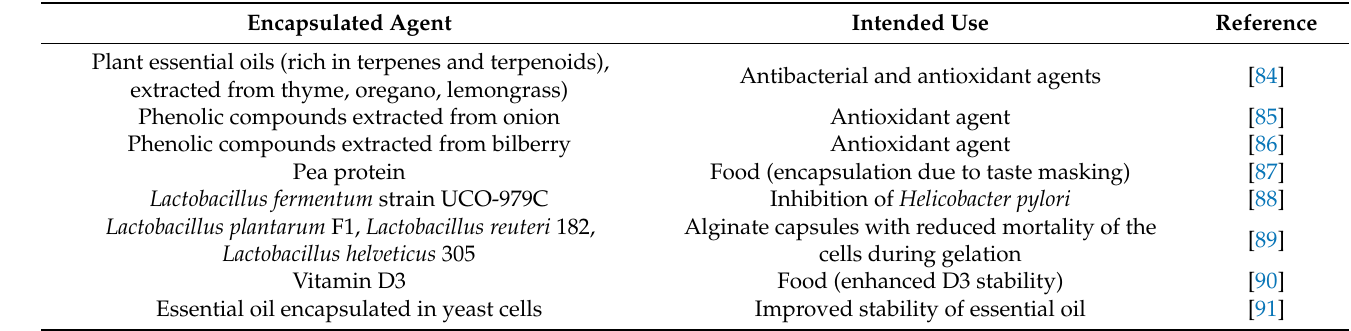
Table 2. Overview of the published use of capsules for